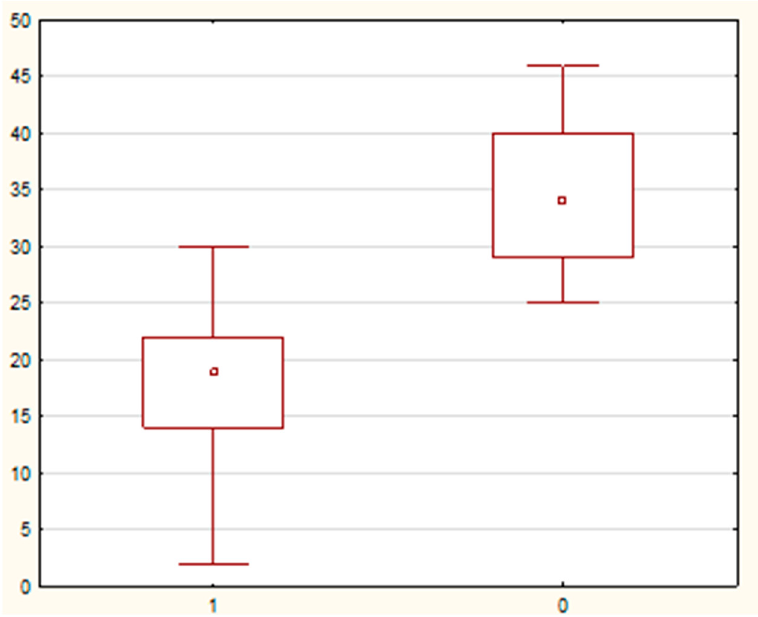
Figure 4. A box-whisker chart showing a comparison of the value of the variable cervical length—mm in the study-1 and control-0 groups.